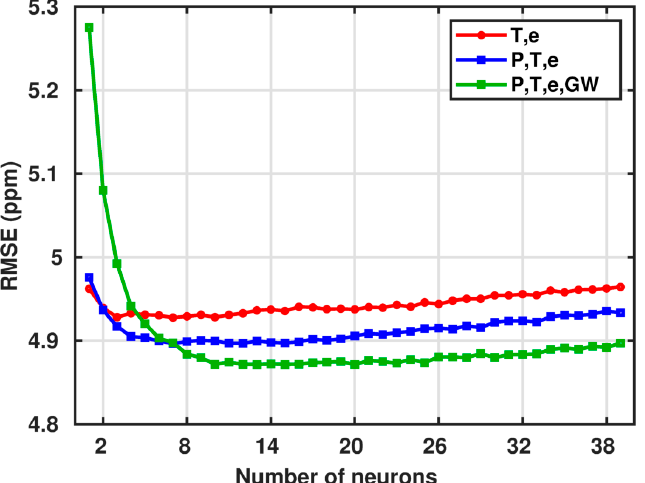
Figure 6. The RMSE value for different numbers of neurons in the hidden layer of the ELM; the red, blue, and green lines indicate [Temperature and Water vapor pressure], [Pressure, Temperature and Water vapor pressure], and [Pressure, Temperature, Water vapor pressure and Wet atmospheric gradients] as input parameters for the ELM, respectively.